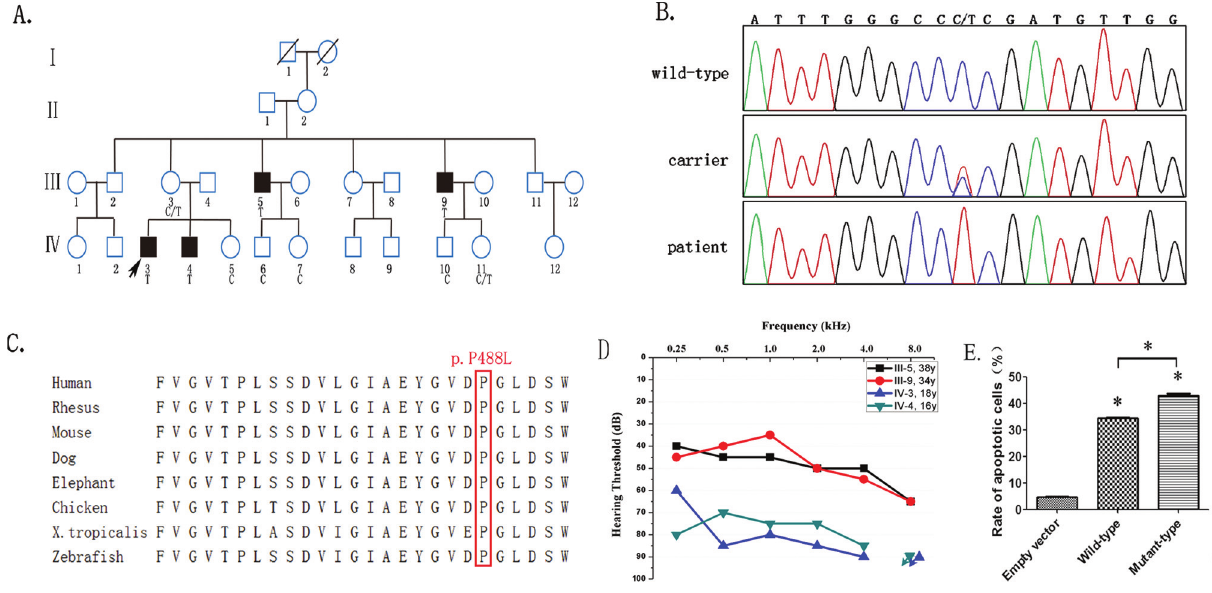
Figure 1 - Variant analysis of AIFM1. (A) Pedigree of Family #36 demonstrates X-linked recessive inheritance hearing loss. Open symbols, unaffected; solid symbols, affected. Squares, male; circles, female; slashed, deceased individual. Slanting arrow, the proband. Family members annotated with the C symbol had no variant in AIFM1, those with the C/T symbol are carriers with the c.1463C>T (p.Pro488Leu) variant in AIFM1, those with the T symbol arepatientswiththec.1463C>T(p.Pro488Leu)variantinAIFM1,andthosewithoutthesymbolswerenotexamined.Segregationofhearinglosswiththe c.1463C>T (p.Pro488Leu) variant in AIFM1 is remarkable in this pedigree. (B) A heterozygous c.1463C>T (p.Pro488Leu) variant of the AIFM1 gene was identified in the carriers and the hemizygous variant was detected in the affected members in this pedigree. (C) Conservation analysis showed that Pro488 in human AIFM1 is conserved across human, rhesus, mouse, dog, elephant, chicken, Xenopus tropicalis , and zebrafish. (D) Pure tone audiometry inthefouraffectedmembersofFamily#36wereindicated.(E)ChangesinHEK293cellsexpressingc.1463C>T(p.Pro488Leu)mutantAIFM1.HEK293 cells were transfected with empty vector, wild-type AIFM1 plasmid and mutant-type AIFM1 plasmid, respectively. After transfection for 48 h, apoptotic cell ratios were determined with annexin-V-PE-staining. Data represent the mean and standard deviation of three experiments. The asterisks indicate sig- nificant differences between the control and experimental groups or differences between the wild-type group and the mutant-type group (* p